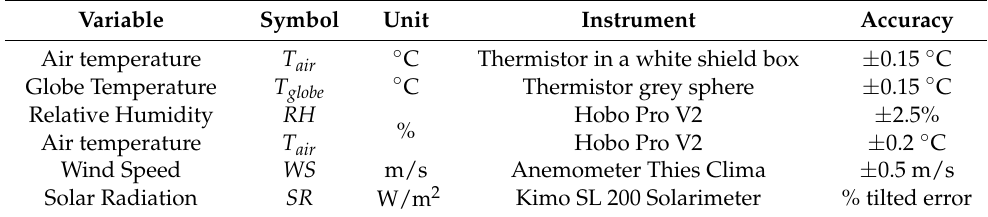
Table 1. Technical details of the measuring